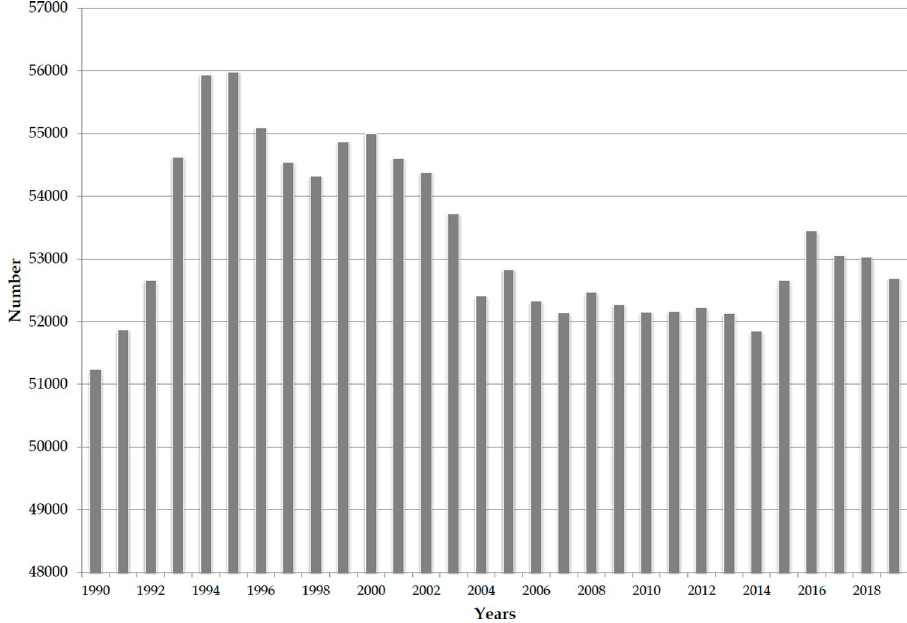
Fig 1. Global suicide deaths by firearm, 1990–2019. Source: GBD estimates